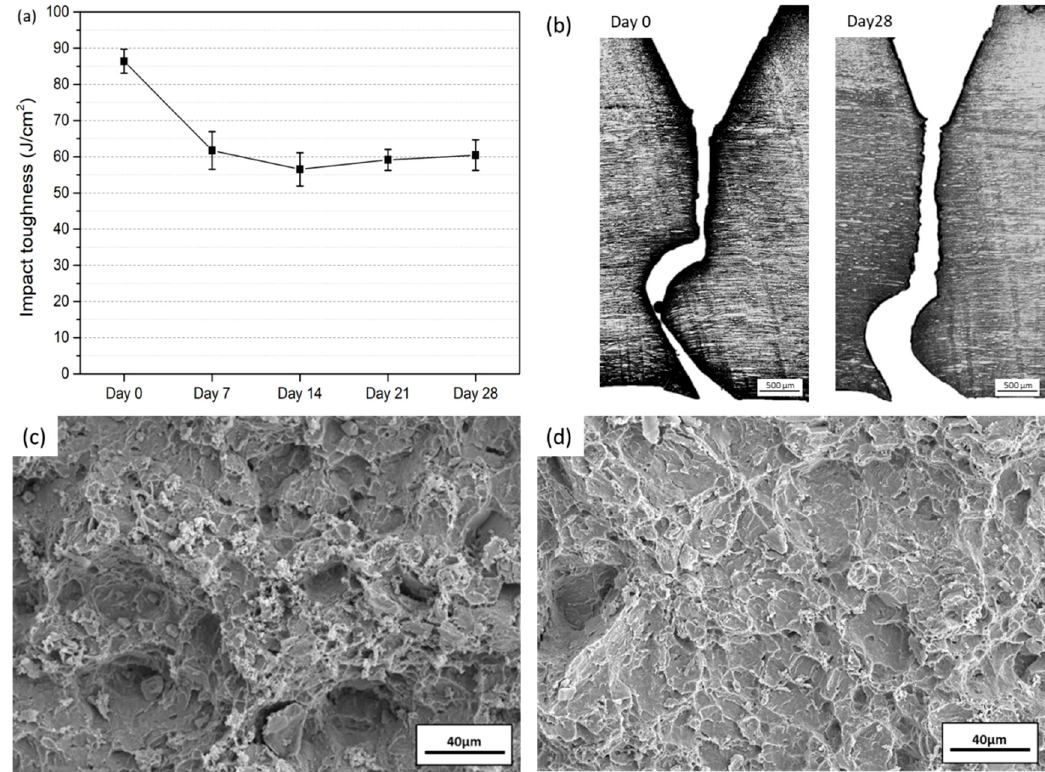
Figure 11. Impact testing: ( a ) impact toughness after immersion, ( b ) cross section of impact specimen, ( c ) fracture surface of before, and ( d ) after immersion 28 days.